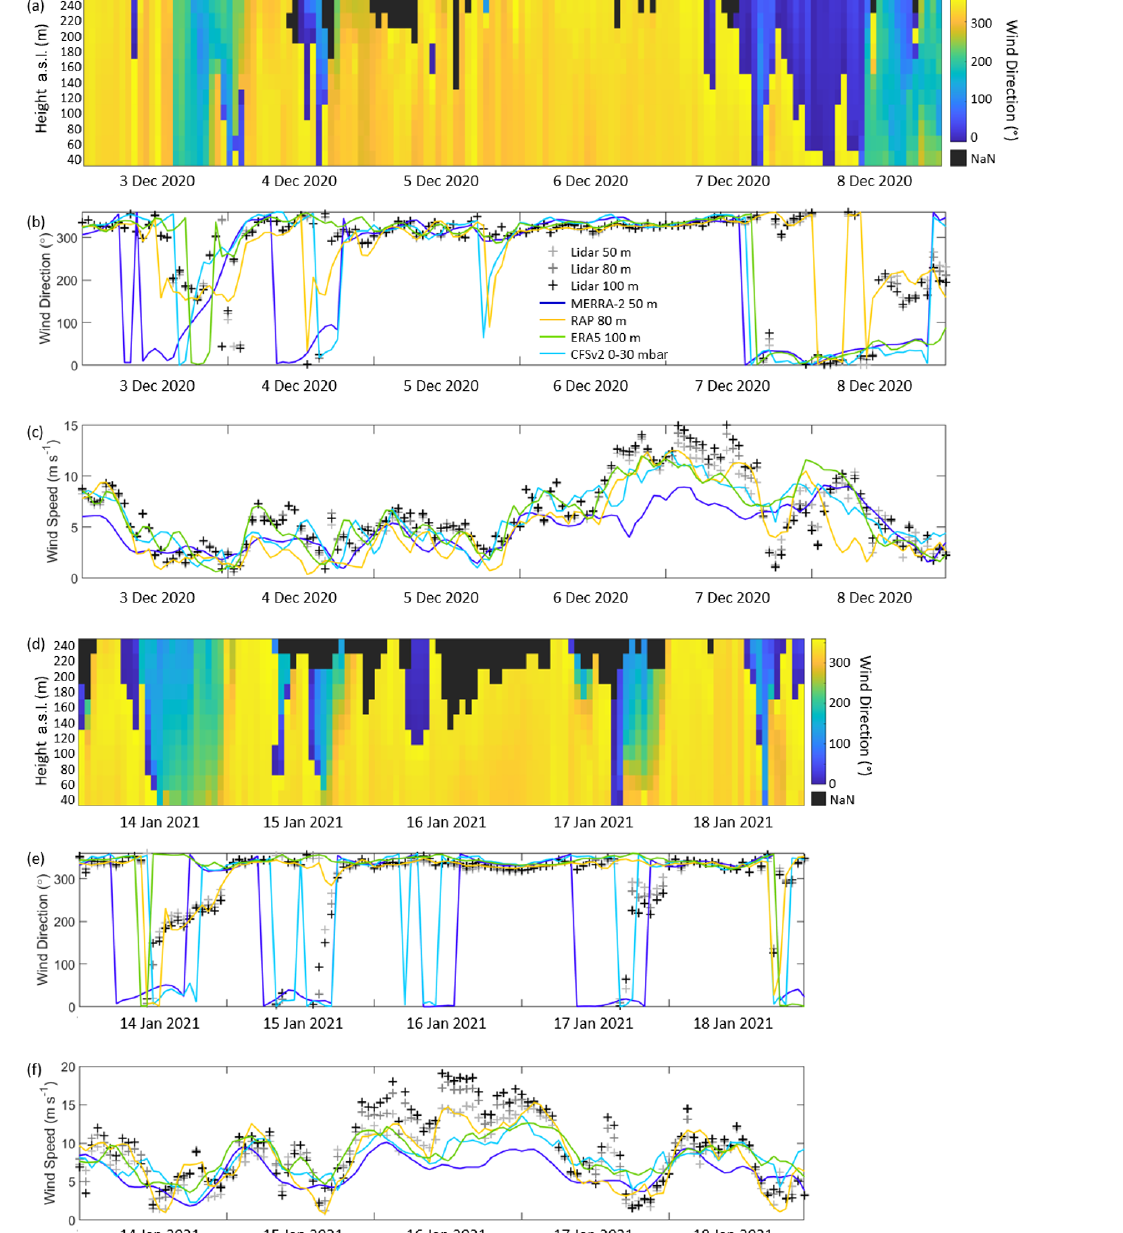
Figure 16. (a,d) Observed wind direction, (b,e) observed and modeled rotor-level wind direction, and (c,f) observed and modeled rotor- level wind speed at Morro